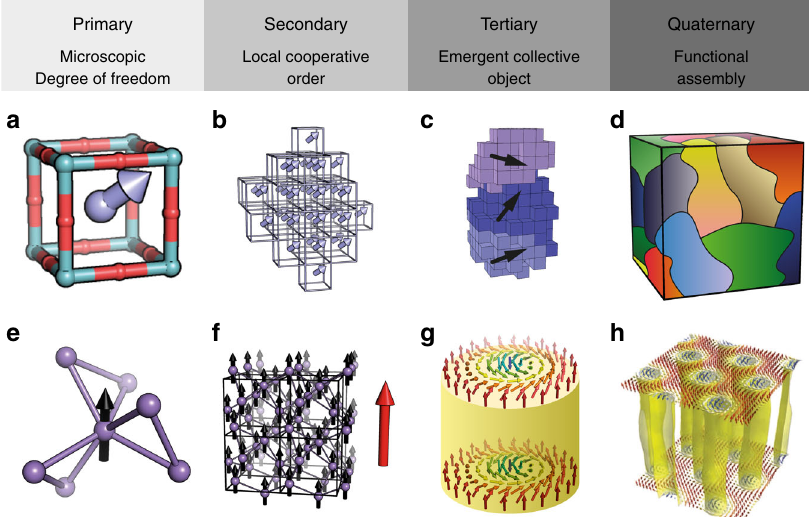
Fig. 1 Hierarchical structures of complex materials. a – d The structure of PbMg 1 = 3 Nb 2 = 3 O 3 relaxor ferroelectric determined in ref. 3 . a At the unit-cell level, the cations are displaced from their high-symmetry positions (arrow) at the centre of the perovskite cages (balls and sticks), and these displacements are correlated with local composition. b Neighbouring unit cells tend to coalign their displacements, forming domains with a collective polarisation. c Collections of nearly aligned domains form larger structures consistent with the polar nanoregion (PNR) model discussed widely in relaxor ferroelectric literature 1 . d Finally, the bulk structure consists of a dense packing of these PNRs (here different PNR orientations are shown in different colours, with gradation re fl ecting the presence of nearly-aligned sub-domains). e – h The magnetic structure of a MnSi skyrmion crystal. e Magnetic moments of Mn atoms (black arrow) on the chiral MnSi lattice couple ferromagnetically to give ( f ) a net local magnetisation (large red arrow). g On larger length scales, the underlying lattice chirality causes this magnetisation to twist on itself, giving rise to a knotting of the magnetisation fi eld known as a skyrmion. Here, arrows are coloured according to the orientation of the magnetisation fi eld, and the yellow surface denotes a region of constant magnetisation surrounding the one-dimensional skyrmion core. h In the bulk, these skyrmions assemble into a crystal phase, which in turn can be observed and manipulated directly. Panel fi gure adapted from ref. 13 . Reprinted with permission from